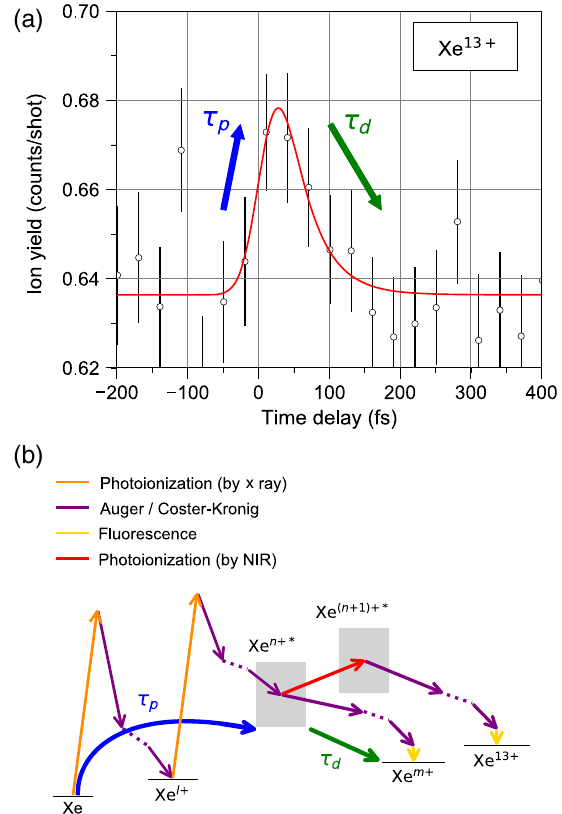
FIG. 1. Ionization of Xe n þ states by the NIR laser in isolated atoms. (a) Xe 13 þ yields as a function of time delay of the NIR- probe pulses (800 nm) with respect to the XFEL-pump pulses (5.5 keV). The experimental results are given by white circles. The red solid curve shows the results of the fit with a product of two exponential functions with increasing and decreasing time con- stants of τ and τ , respectively. The function was convoluted with p d a Gaussian function accounting for the instrumental function with a ≃ 10 fs and τ ≃ 40 fs are the time constants for the width σ . τ p d population and depopulation of Xe n þ ð n ≤ 12 Þ states, respectively. The zero time delay was obtained by the fit with an accuracy of (cid:2) 20 fs. The fitting parameter σ ≃ 20 fs (rms) or ∼ 50 fs (FWHM) gives the time resolution. All data points in the time delay range from − 800 to þ 1500 fs have been used for the fit. (b) Schematic diagram for the ionization of the Xe n þ ð n ≤ m Þ states which decay into Xe m þ ð m < 13 Þ states without NIR probe. The orange, purple, yellow, and red arrows show the photoionization of the Xe atoms and Xe ions by x ray, Auger cascades of core-ionized Xe ions, fluorescence, and the photoionization of transient Xe n þ states by the NIR laser,